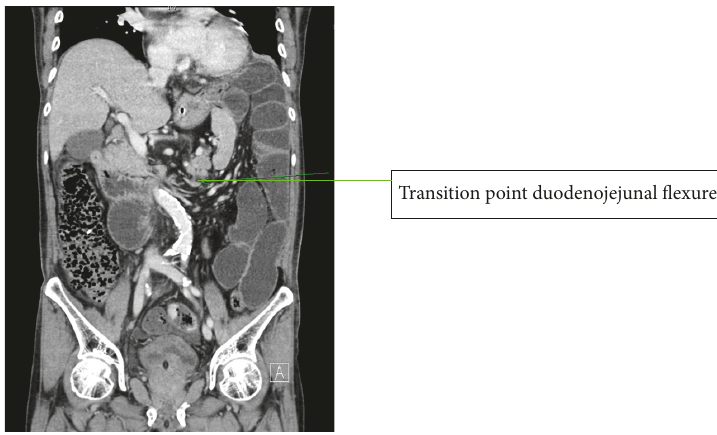
Figure 1: Coronal slice of CT showing duodenojejunal flexure transition point in the left hemiabdomen.